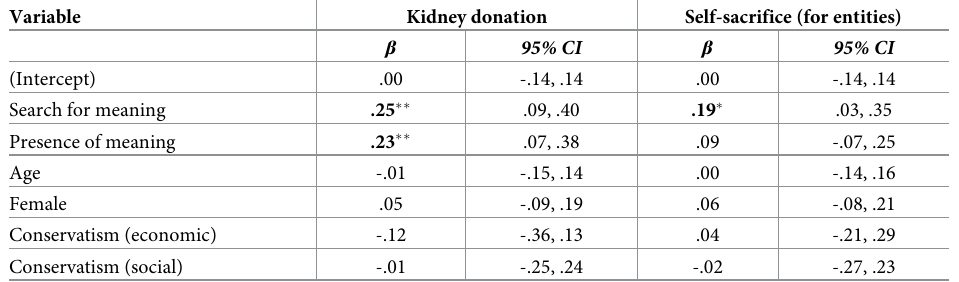
Table 2. Multiple regressions predicting costly prosociality with search for meaning and other variables in Study